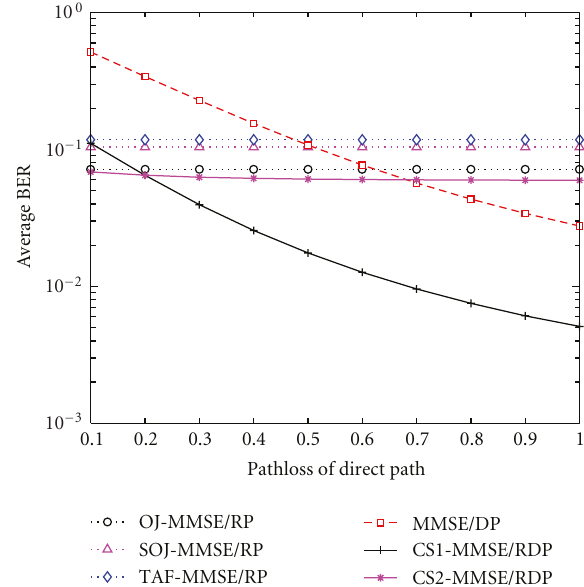
Figure 7: BER versus number of antennas in downlink ( p = 0 . 4, SNR1 = SNR2 = 15dB) .